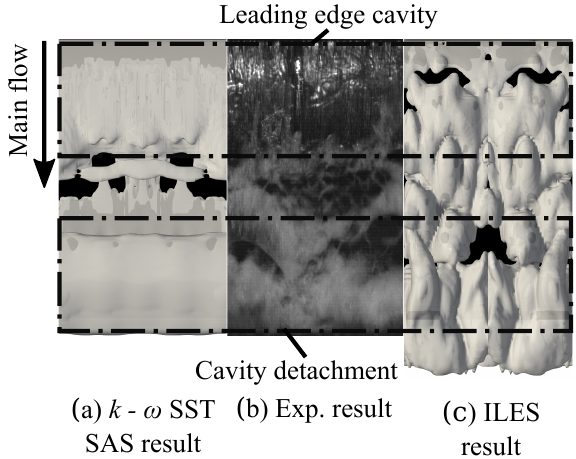
Figure 6. Comparison of the leading edge cavity and cavity detachment between numerical simulation results and the experimental result for instant 4 (cid:13) in horizontal plane using iso-contour of α = 0.1.